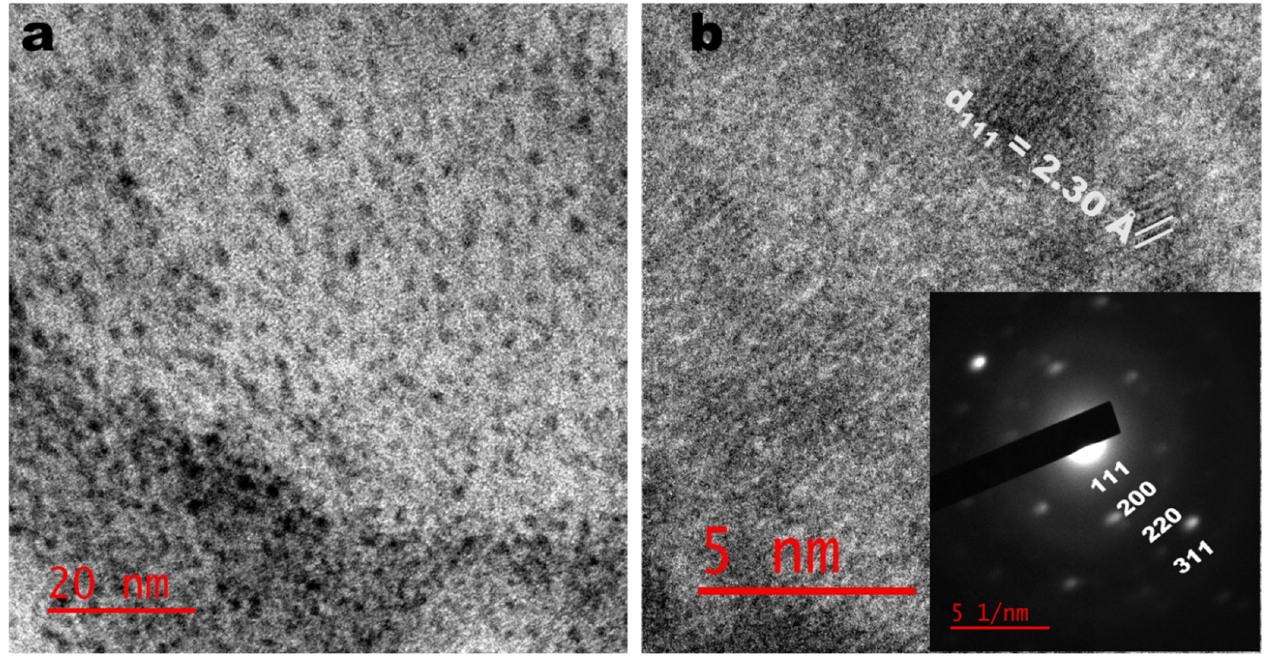
Figure 3. TEM ( a ) and HRTEM ( b ) images of CE synthesized PtNPs (Inset: SAED).